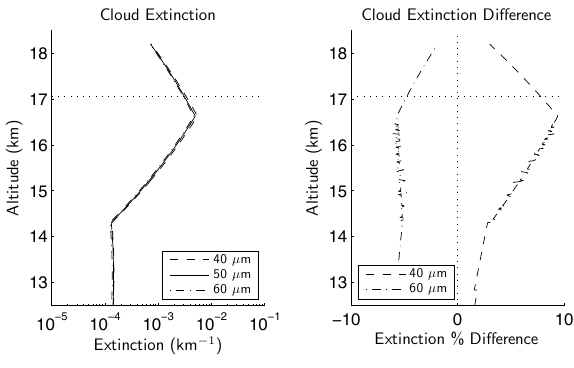
Fig. 15. Retrieved cirrus extinction for varying assumed particle Fig. 15: Retrieved cirrus extinction for varying assumed par- Fig. 15: Retrieved cirrus extinction for varying assumed par- size, scan 47626029. ticle size, scan 47626029. ticle size, scan 47626029.